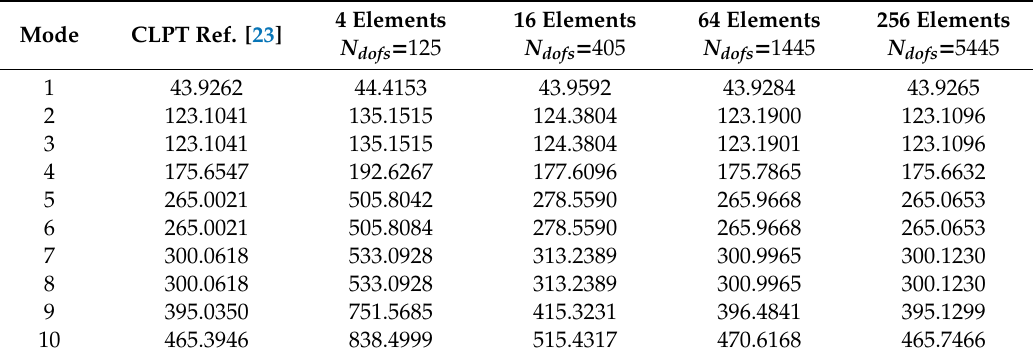
Table 3. Convergence features of the numerical approach and comparison of the first ten natural frequencies (Hz) with the semi-analytical solutions provided by Reddy [23] for a simply-supported thin plate with a through-the-thickness uniform distribution of the reinforcing fibers. CLPT: classical laminated plate theory.